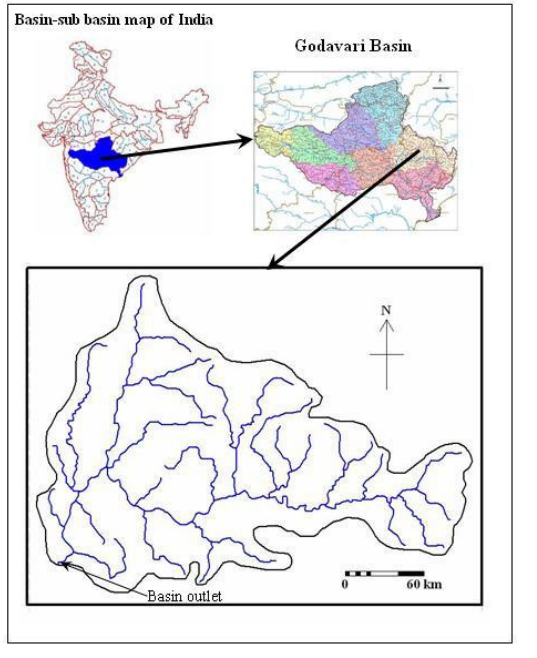
Figure 1. Location map of Indravati